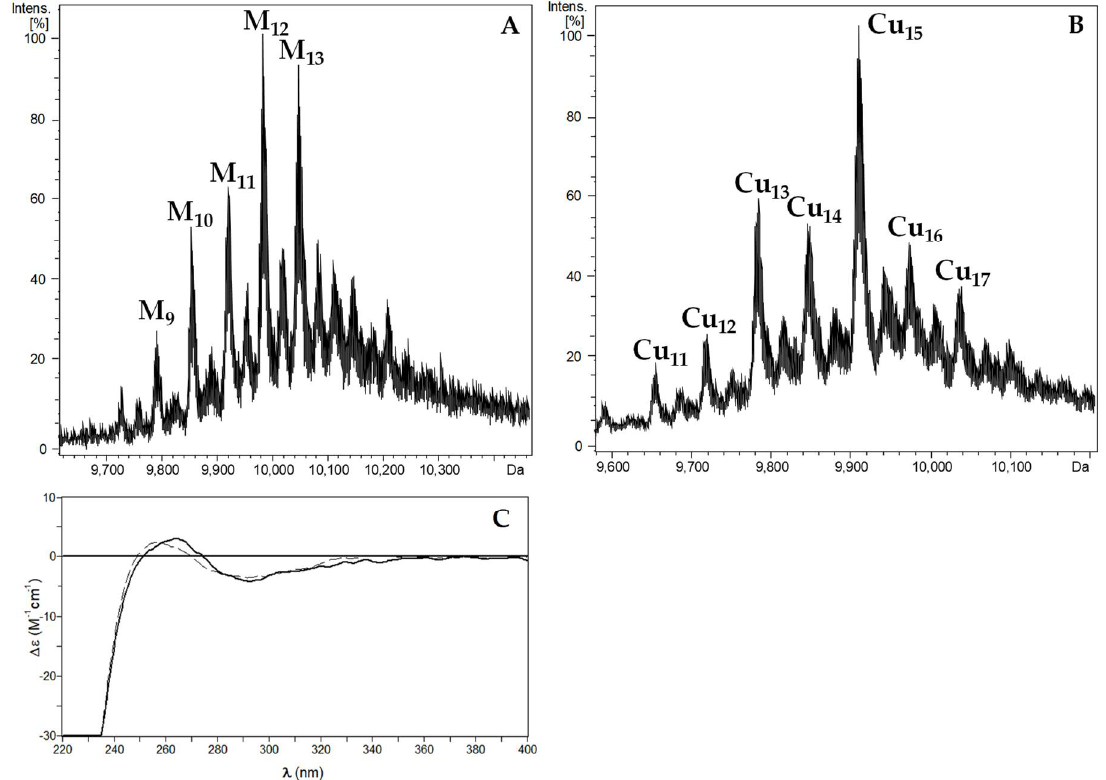
Figure 5. In vivo Cu(I) binding assessment of recombinant PbrMT1 and PbrMT2. Deconvoluted ESI-MS spectra of ( A ) Cu-PbrMT1 and ( B ) Cu-PbrMT2 productions. ( C ) CD spectra of PbrMT1 (solid) and of PbrMT2 (dashed) productions.